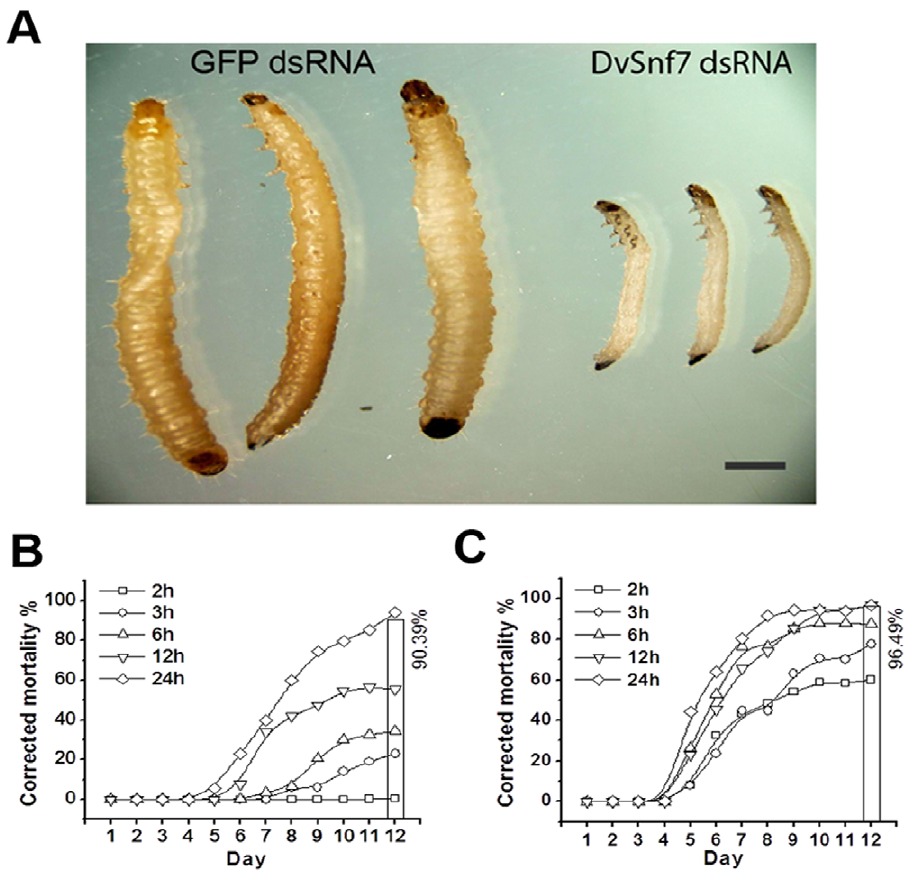
Figure 1. dsRNA DvSnf7 direct toxicity in Western Corn Rootworm (WCR, Diabroticavirgiferavirgifera ) larvae. A) Growth inhibition in second instar larvae fed on diet overlaid with 1000 ng/mL DvSnf7 dsRNA for 5 days compared to larvae fed with control diet containing similar concentration of GFP dsRNA. Scale bar =1 mm. Mortality of WCR larvae to varying exposure times of DvSnf7 dsRNA incorporated into diet bioassay at B) 50 ng and C) 1000 ng of dsRNA/mL diet. Open columns represents the mortality of 12-day continuous feeding.